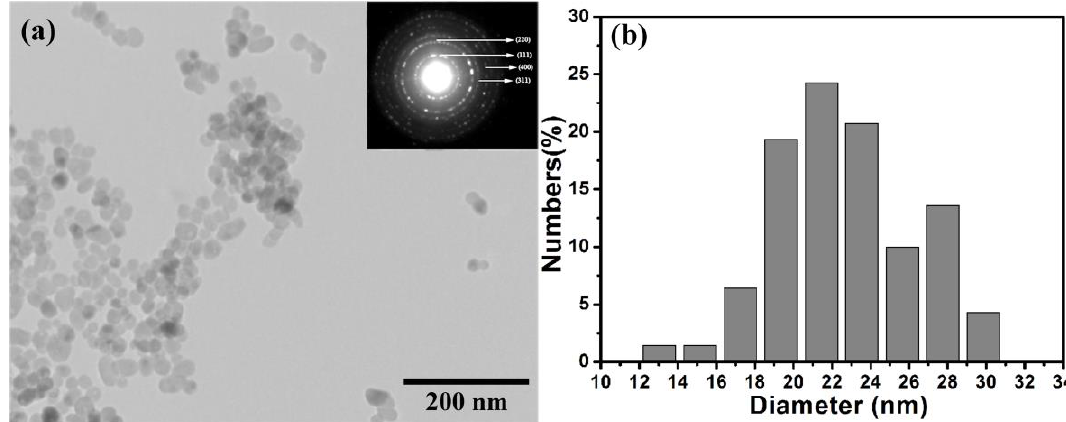
Figure 1. ( a ) TEM image of the as-synthesized CaF 2 nanocrystals. Inset in ( a ) represents the corresponding SAED pattern. ( b ) Particle size distribution of CaF 2 nanocrystals.